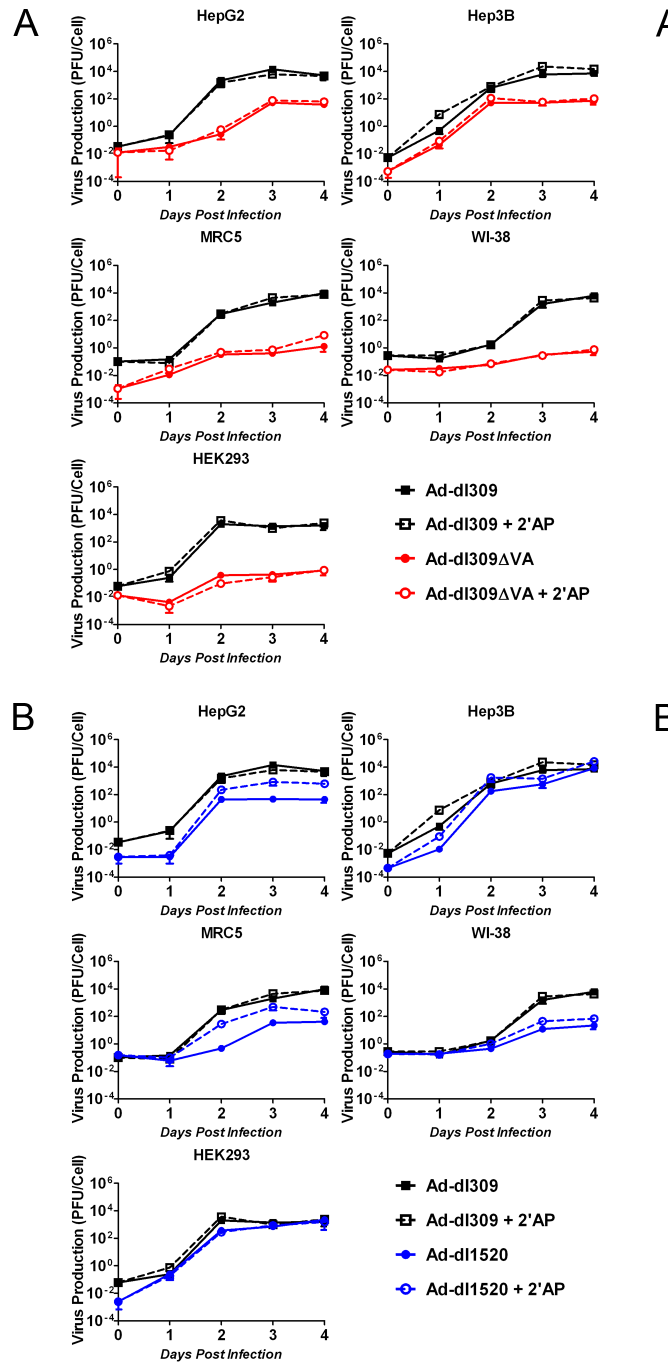
Figure 3. 2 9 AP increases the replication of adenoviruses with an E1b deletion or with both E1b and VA-RNA deletions. (A) Cells were infected in duplicate with Ad-dl309 and Ad D E1b at an MOI of 1 PFU/cell 1 hour prior to treatment with medium containing no drug or 2.5 mM 2 9 AP. Cells and media were harvested at 1 hr (day 0) as well as 1, 2, 3 and 4 days post-infection. Virus yields were determined using plaques assays on HEK293 cells. (B) Cells were infected with Ad D E1b and Ad D E1b D VA at an MOI of 1 GFU/cell 1 hour prior to addition of medium containing no drug or 2.5 mM 2 9 AP. Cells and media were harvested at 1 hr (day 0) as well as 1, 2, 3 and 4 days post-infection. Virus yields were determined by titration in Hep3B cells. Error bars correspond to + / 2 SD.